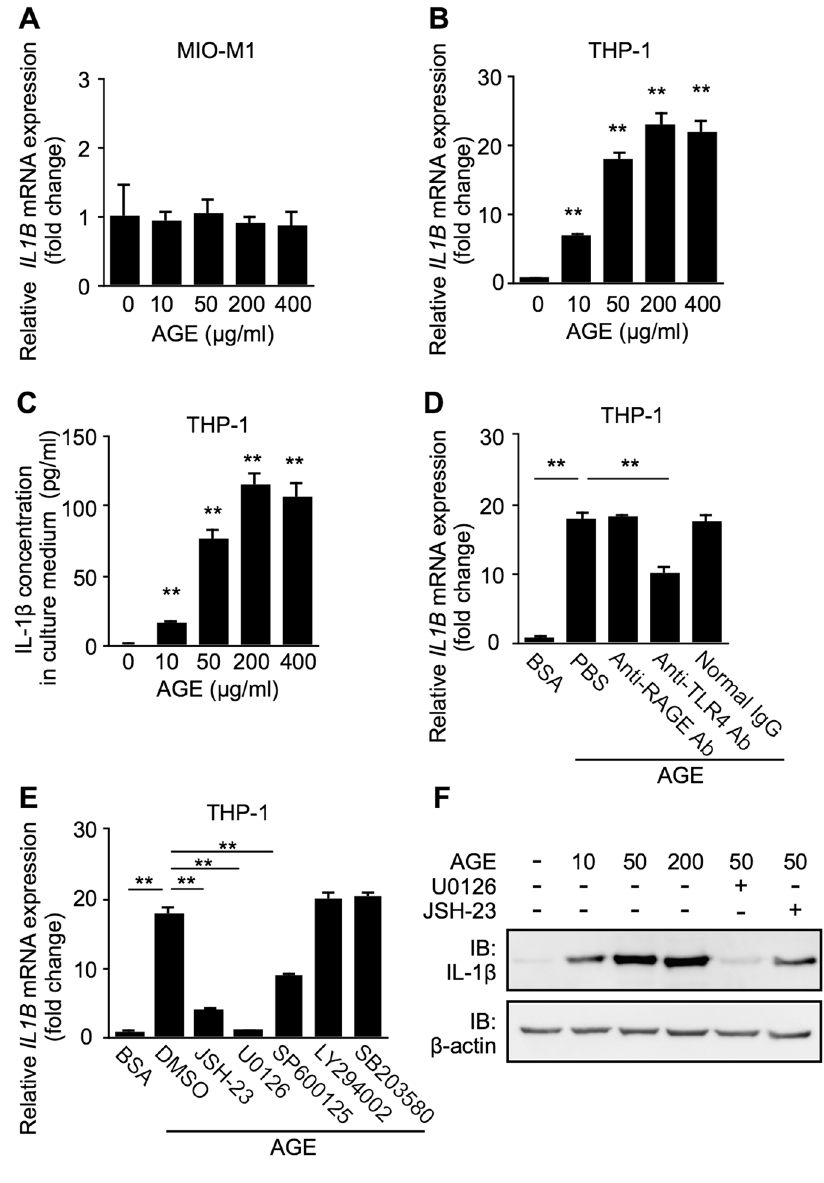
Figure 4. AGE-induced expression of IL-1 β in macrophages via TLR4 signaling. ( A ) MIO-M1 was treated with AGE-BSA (10–400 μ g/ml) for 24 hours, and IL1B expression levels were analyzed. ( B , C ) THP-1 was treated with AGE-BSA (10–400 μ g/ml) for 24 hours, and IL1B gene expression levels in cell lysates ( B ) and IL-1 β protein levels in culture media ( C ) were analyzed. ( D ) THP-1 was pretreated with neutralizing antibodies against RAGE (10 μ g/ml) and TLR4 (10 μ g/ml), in comparison with control normal IgG (10 μ g/ml) for 30 minutes followed by treatment with AGE-BSA (50 μ g/ml) for 24 hours, and IL1B gene expression levels were analyzed. ( E , F ) THP-1 was pretreated with each inhibitor at 10 μ M 30 minutes before application with AGE-BSA (50 μ g/ml) for 24 hours, and IL1B mRNA ( E ) and protein ( F ) expression levels were analyzed. ** p < 0.01 (n = 8 per group). Full-length blots are presented in Supplementary Fig.